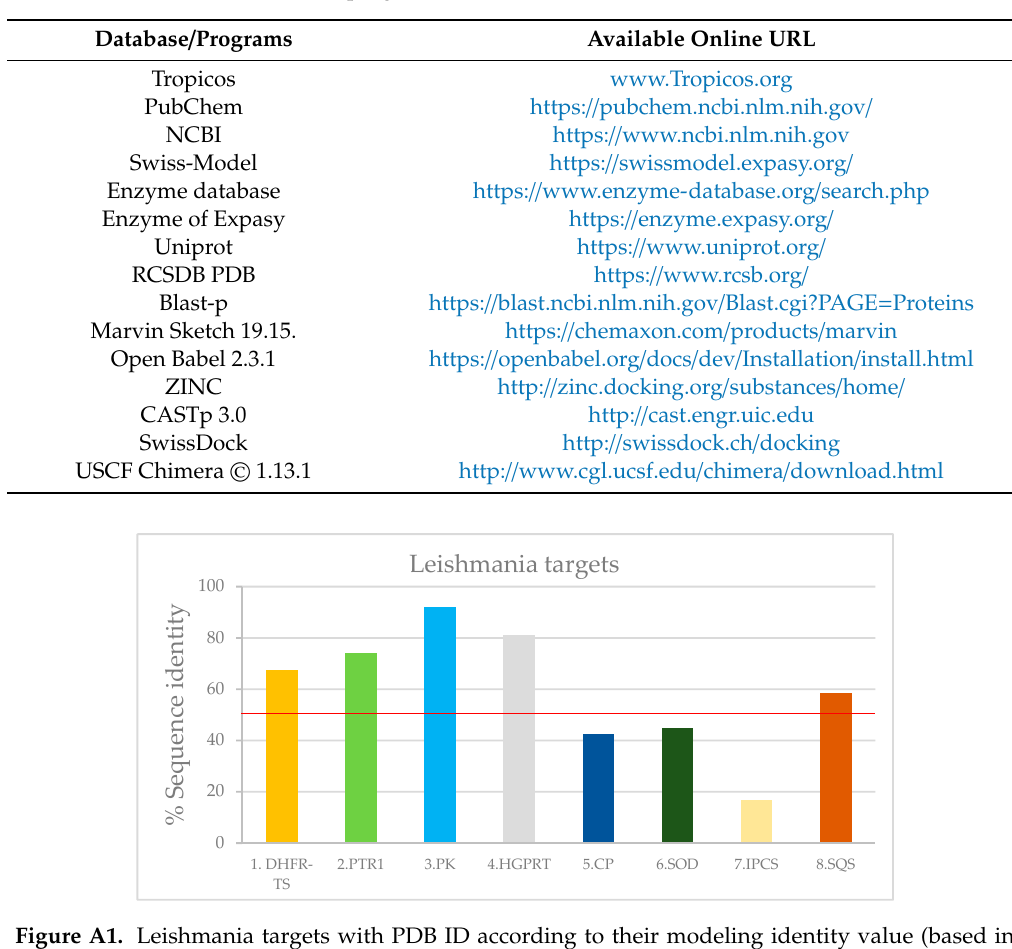
Figure A2. Structural Models of PTR1 (1E7W) and DHR (3O4R) targets. ( A ) Overlapping of Leishmania (sky blue) and H. sapiens (salmon) enzymes. Green zones indicate position of interest in Figure A2. Cont humans. ( B ) Alignment sequence. The aligned regions are indicated in the colored boxes, root mean square deviation (RMSD) as gray blocks, “*” identical or preserved residues; “:” Preserved substitutions and “.” Semi-preserved substitutions.